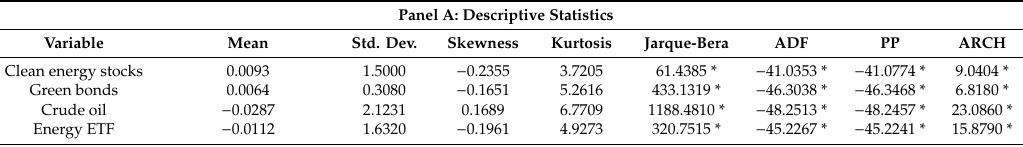
Table 1. Descriptive statistics and correlation